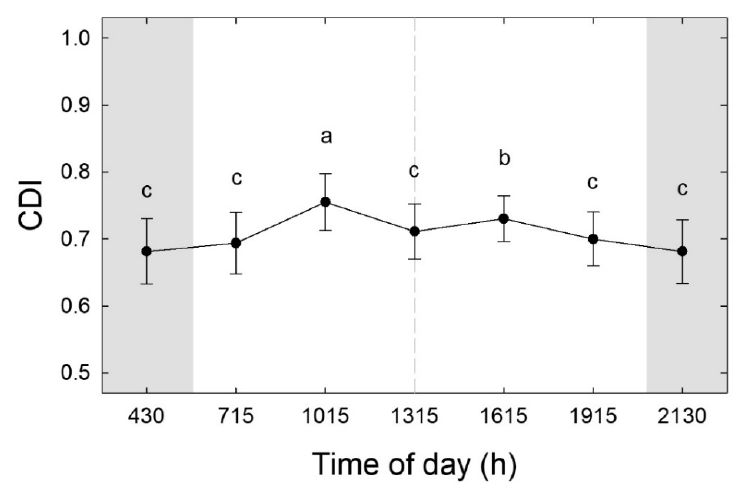
Figure 7. Daily trend of fruit colour development index (CDI) in peach and nectarine cultivars with east ‐ and west ‐ exposed fruit pooled together. Grey bands highlight night ‐ time before sunrise and after sunset, whereas dashed vertical line represents solar noon. Error bars represent 95% confidence intervals of the estimates and different letters show significant differences ( p < 0.05) after a Bonferroni post hoc test.